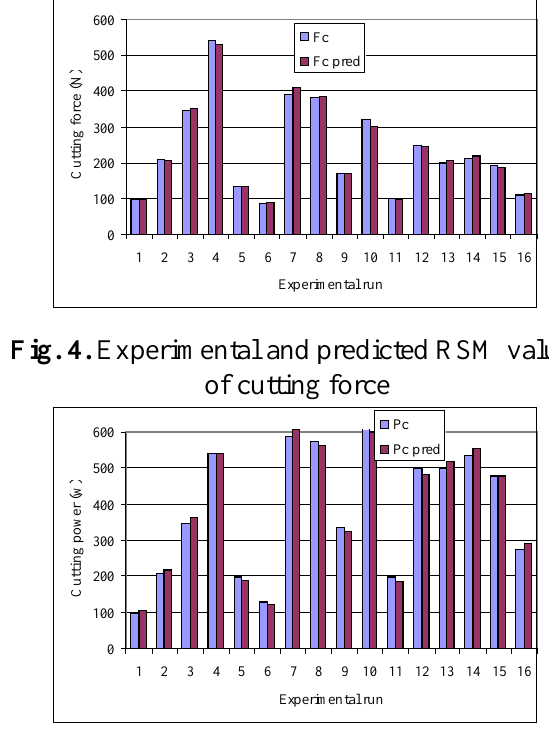
Fig. 5. Experimental and predicted RSM values of specific cutting force